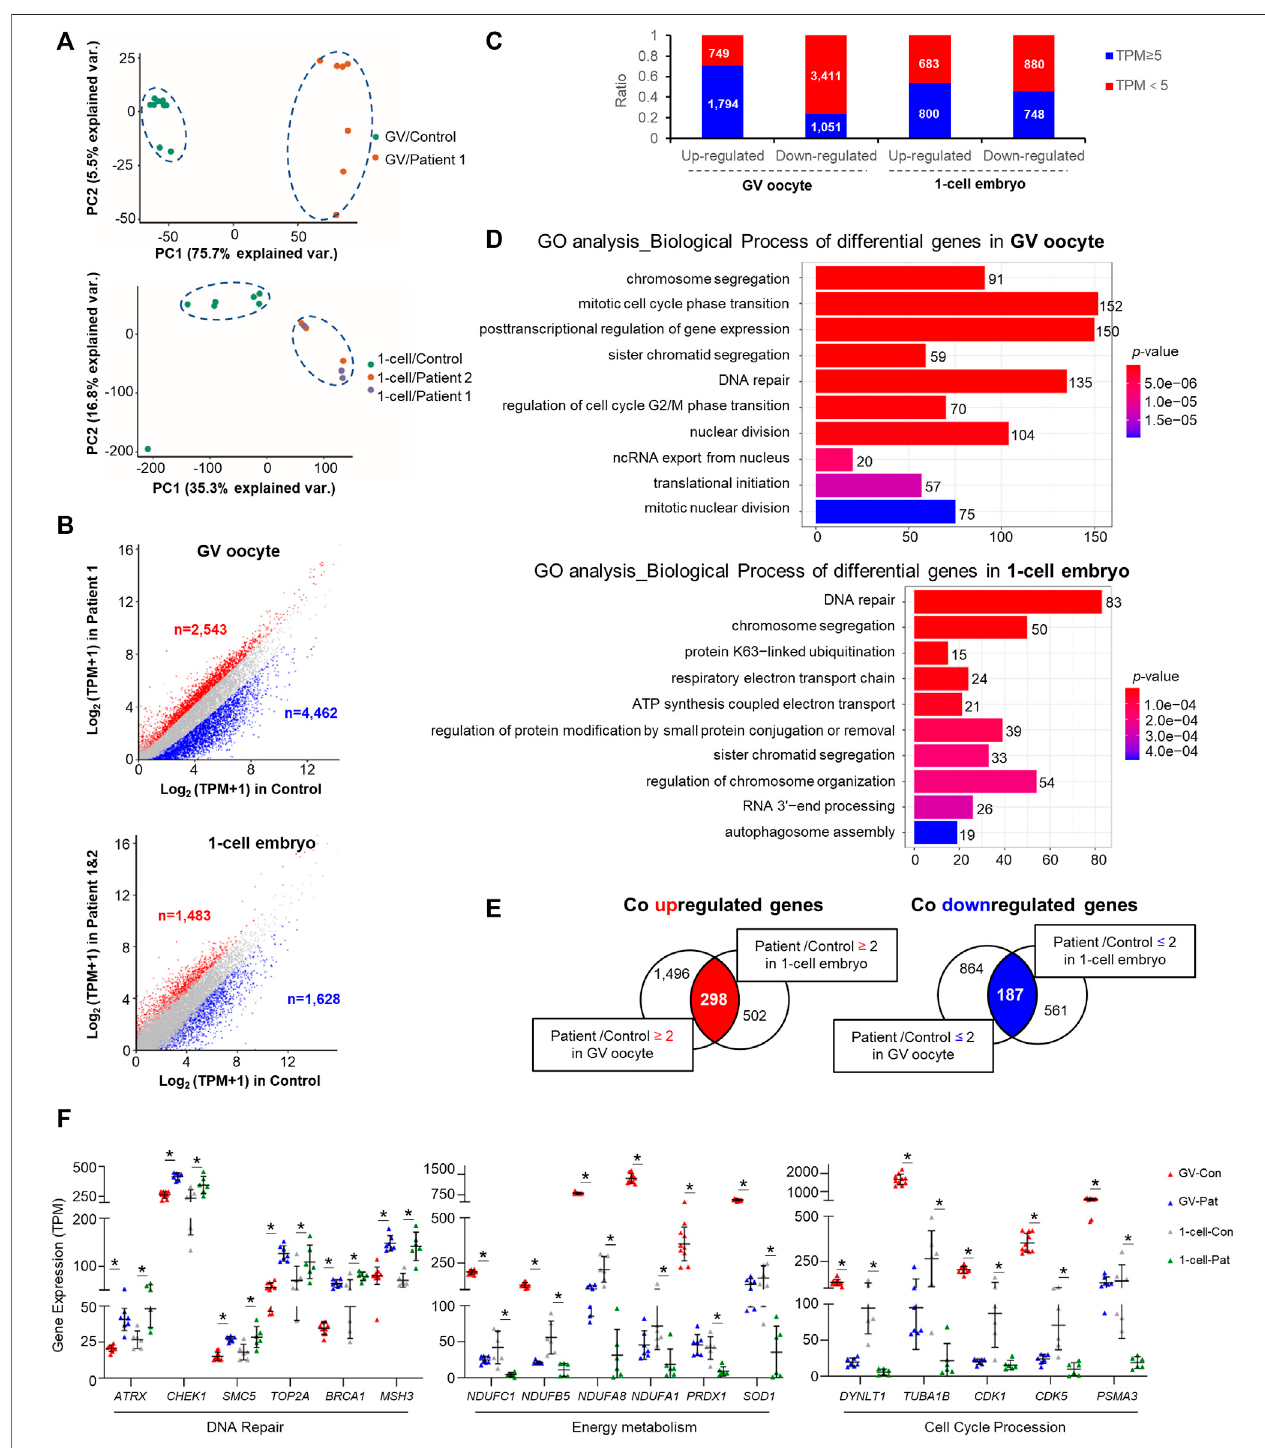
FIGURE 3 | Changes in oocyte and embryo transcriptomes in the TRIP13 variants. (A) Principal component analysis (PCA) of gene expression in germinal vesicle (GV) oocytes and 1-cell embryos of TRIP13 variants and controls. (B) Scatter plot comparing the number of upregulated and downregulated gene transcripts between the TRIP13 variant in patient and control GV oocytes (upper) or 1-cell embryos (lower). Transcripts whose levels increased or decreased by more than 2-fold in the TRIP13 variant patients are highlighted in red or blue, respectively. (C) Ratio of the number of differentially expressed transcripts based on transcripts per million (TPM) prevalence in GV oocytes and 1-cell embryos. (D) Enriched top 10 biological processes of differentially expressed transcripts in GV oocytes and 1-cell embryos obtainedviaGeneOntology(GO)analysis.Transcript numbersforeachbiologicalprocess areprovidedontheright. (E) Venndiagramsshowingthesharedupregulated (red region) or downregulated (blue region) transcripts between the control and GV oocytes (left) or 1-cell embryos (right). (F) Scatter plots of mRNA expression of selected transcripts related to three functions in the TRIP13 variants and control groups. Data are the mean ± SD. * p < 0.01, Student ’ s t-test.